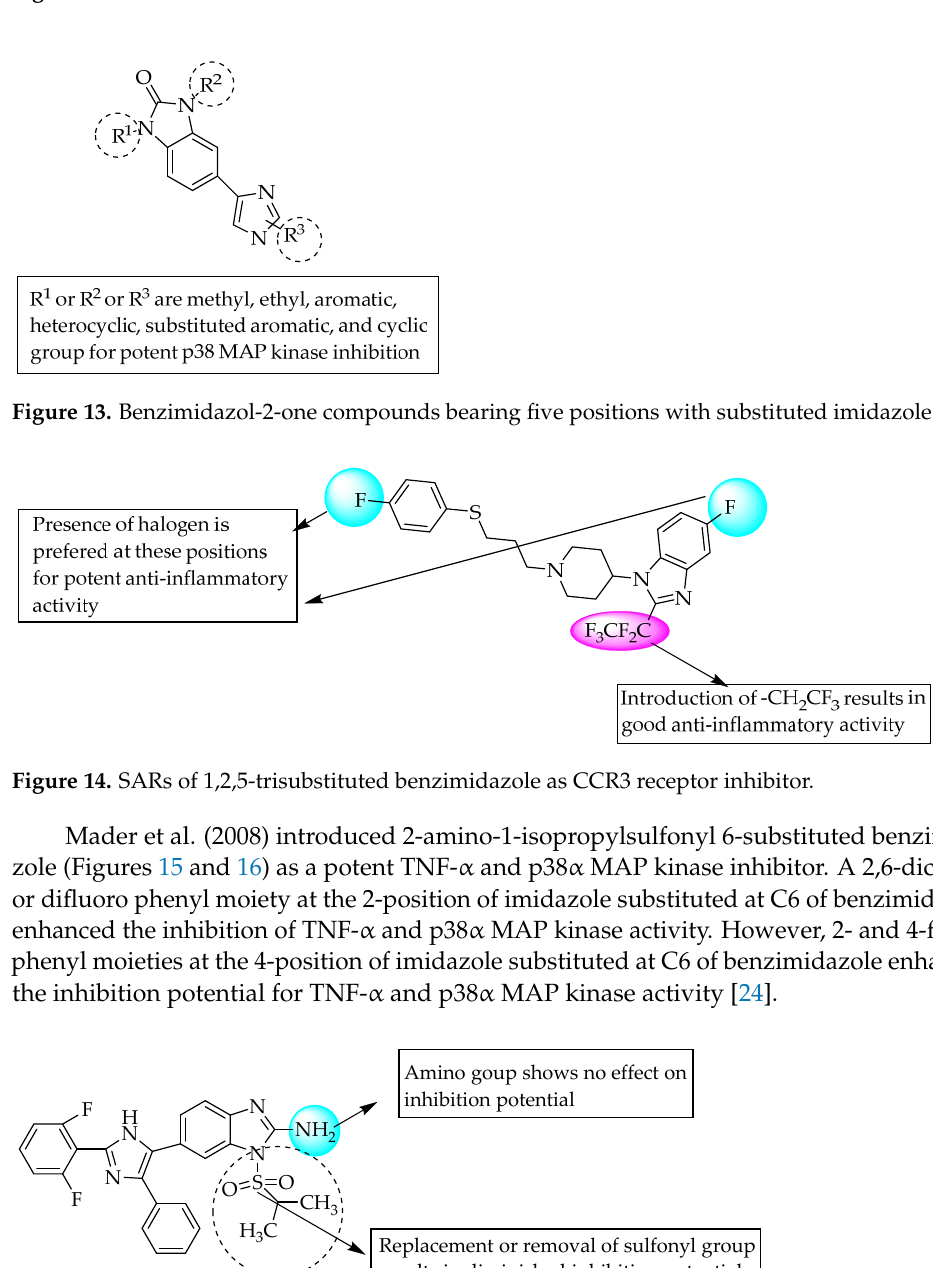
Figure 15 . SAR of 2-amino-1-isopropylsulfonyl 6-substituted benzimidazole. Figure 15. SAR of 2-amino-1-isopropylsulfonyl 6-substituted